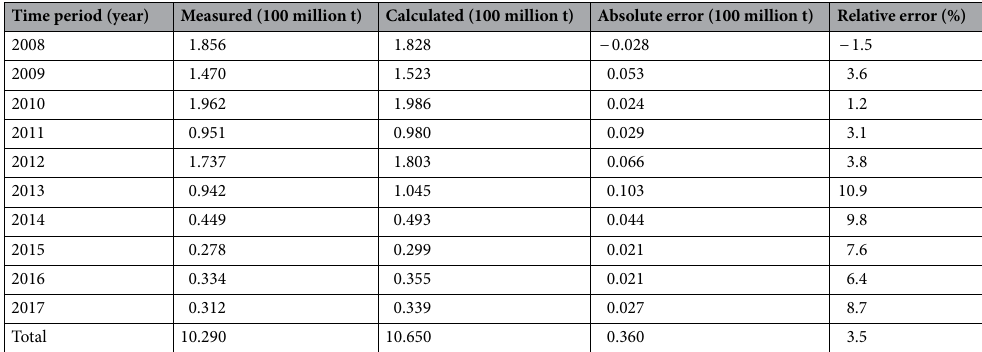
Time period (year)